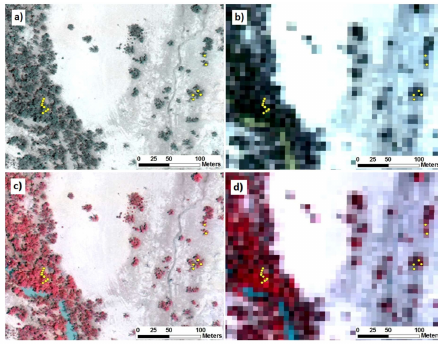
Figure 4. WorldView-3 image displayed in RGB using bands Blue, Green, Red ( a , b ) and bands NIR1, Red and Blue ( c , d ) showing the same sample sites in Landscape B at 1.24 m ( a , c ) and 7.5 m ( b , d ) spatial resolutions. Yellow dots denote tree GPS